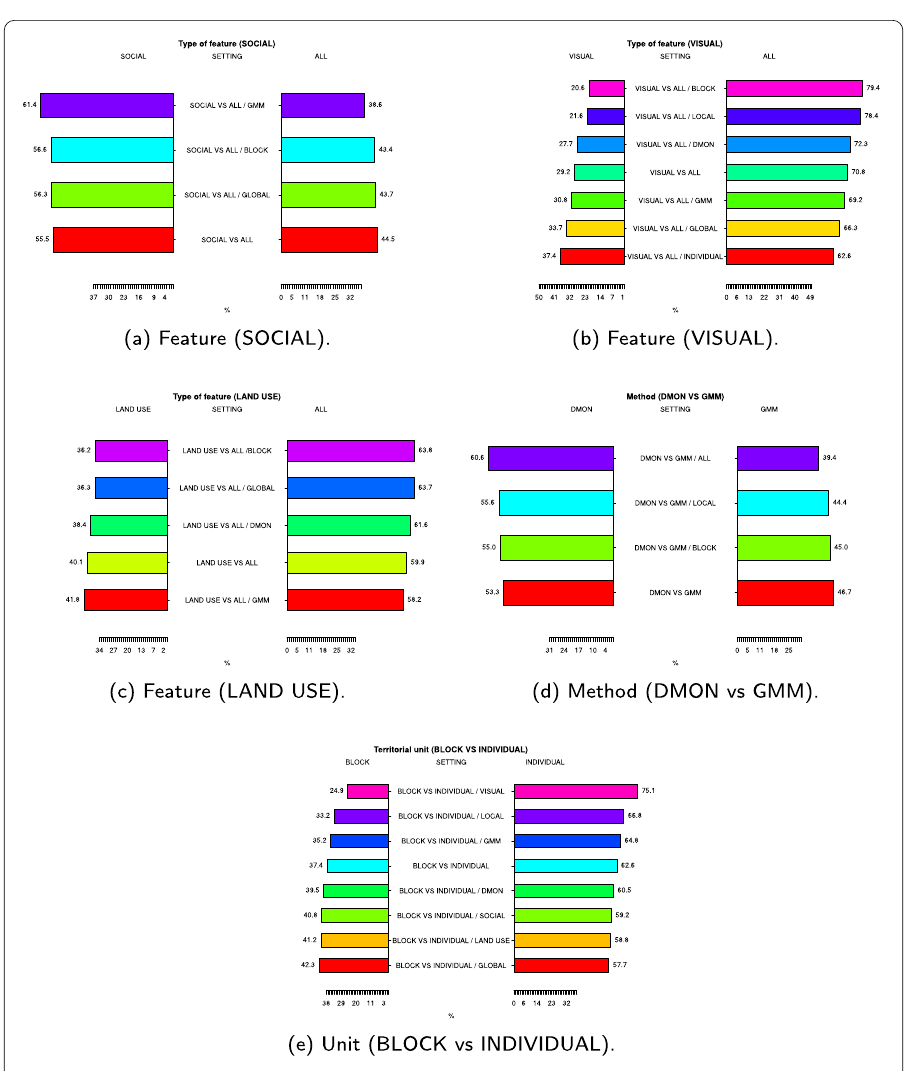
Figure 6 Results of the survey. Each plot shows the results of the survey per factor, sorted in decreasing order from top to bottom according to statistical significance. Each of the five factors shows a clear trend in favor